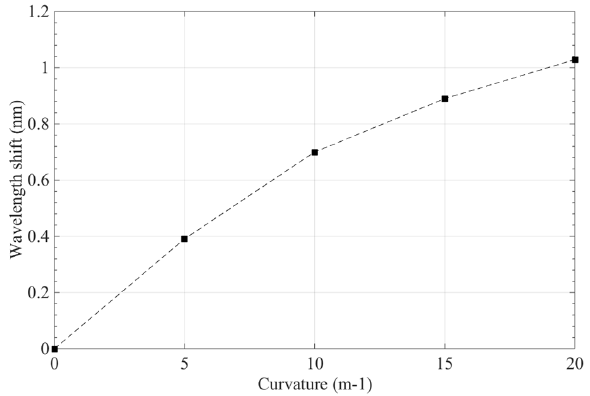
Figure 13. The wavelength shift of FBG sensor for a morphing wing.